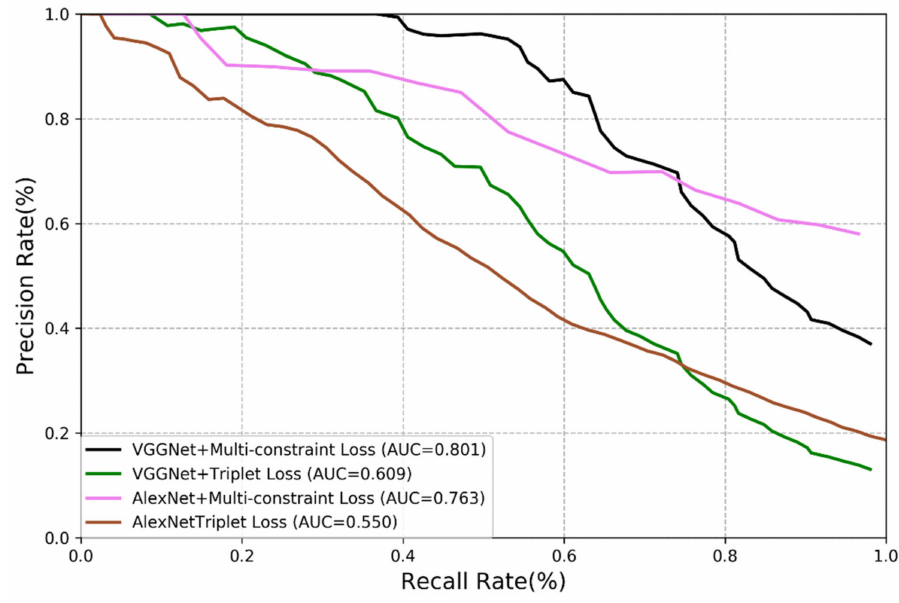
Figure 7. Comparison of multi-constraint loss and triplet loss (New College dataset).